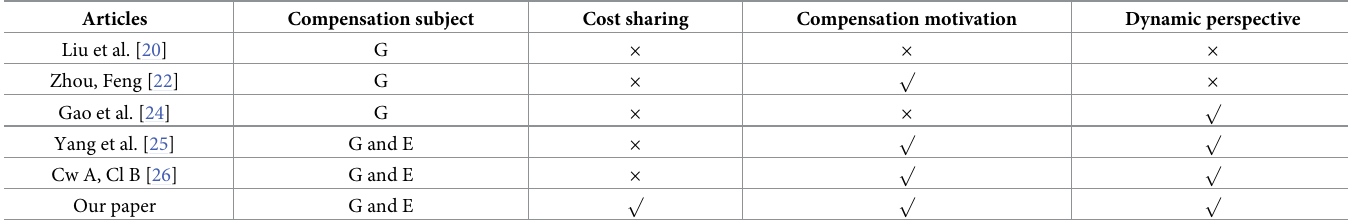
Table 1. Summary of the major literature review (G: Government; E: